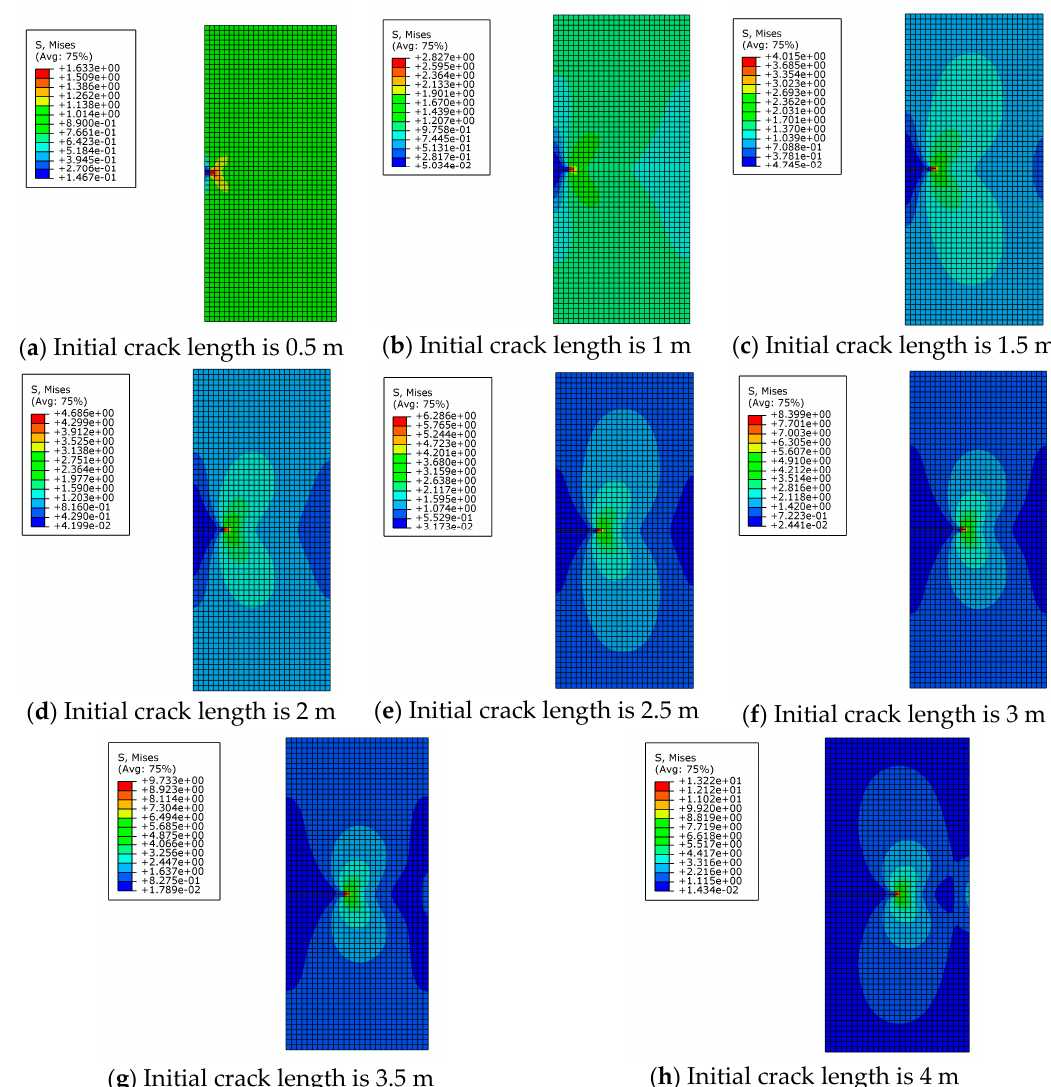
Figure 3. The von Mises stress distribution for different initial crack lengths.